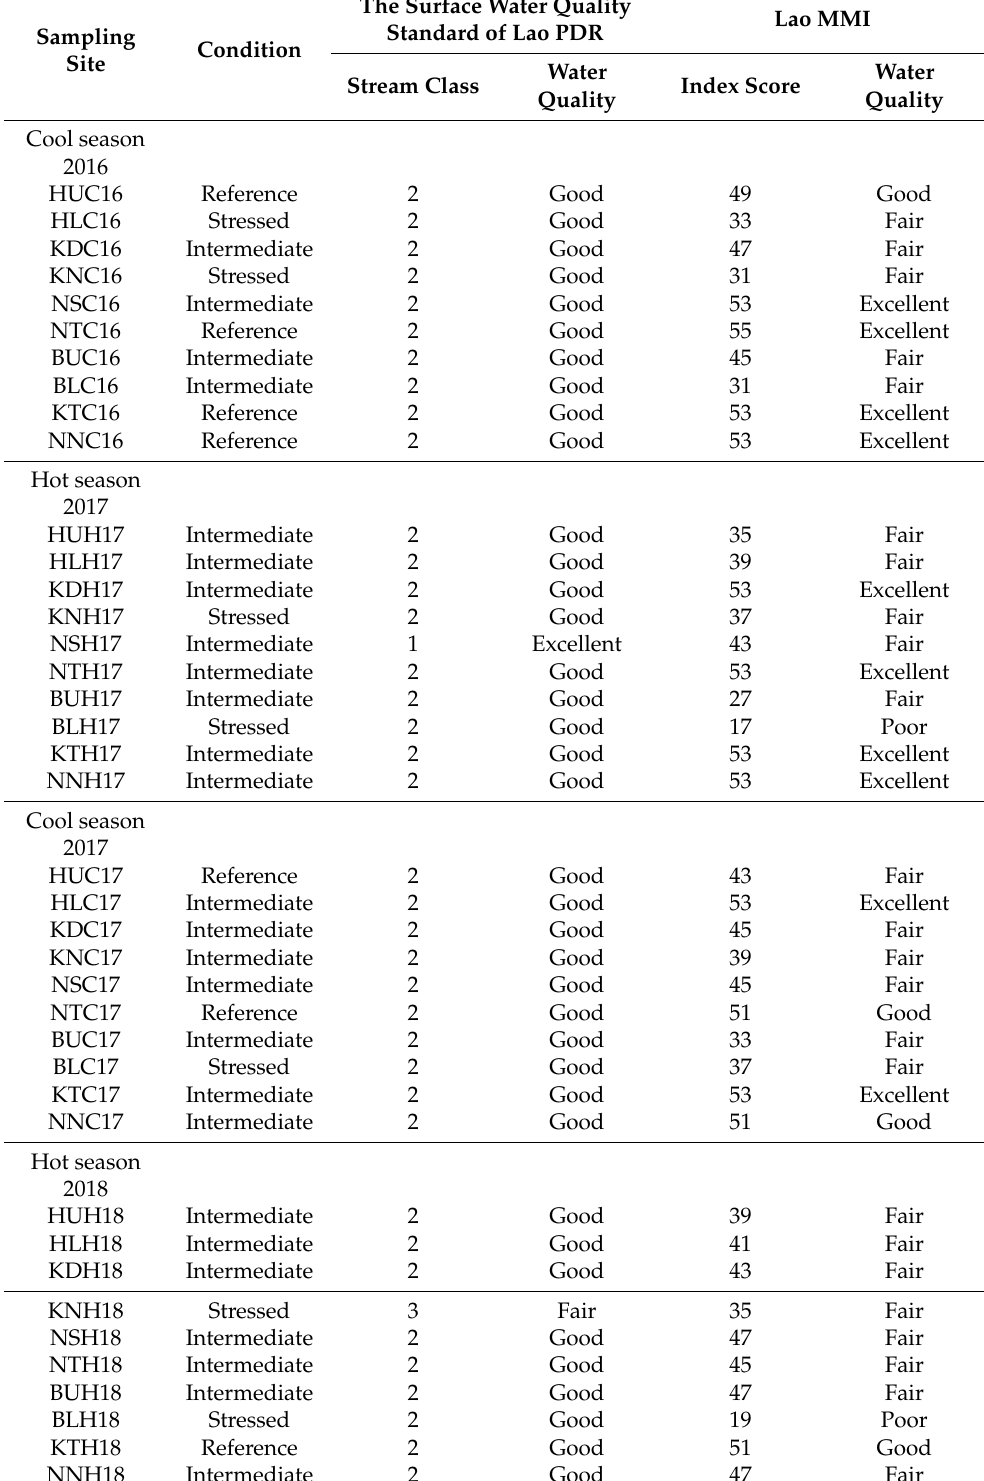
Table 8. Water quality of 40 sampling sites (wadeable rivers and streams) in Lao PDR assessed by using surface water quality standards of Lao PDR (physicochemical method) and the developed Lao